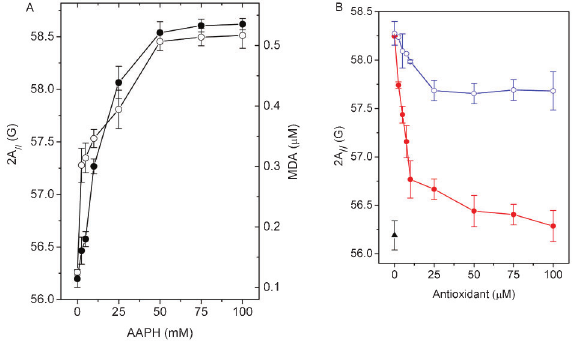
Figure 5. A , EPR parameter 2A // of 5-DSA in erythrocyte ghost membranes (filled circles) and MDA formation (open circles) as a function of the concentration of the oxidizing agent AAPH after incubation for 3 h at 37 6 C. B , Antioxidant activity of 4-NC (filled circles) and a -tocopherol (open circles), as evaluated by the spectral parameter 2A // . Non-oxidized membranes were used as the control (filled triangle). The erythrocyte membranes were previously incubated with the antioxidants for 1.5 h at 37 6 C and then incubated with the radical initiator AAPH (50 mM, for 3 h at 37 6 C). EPR: electron paramagnetic resonance; 5-DSA: 5-doxyl stearic acid; MDA: malondialdehyde; AAPH: 2,2 9 -azobis(2- aminopropane) hydrochloride; 4-NC: only 1 G.